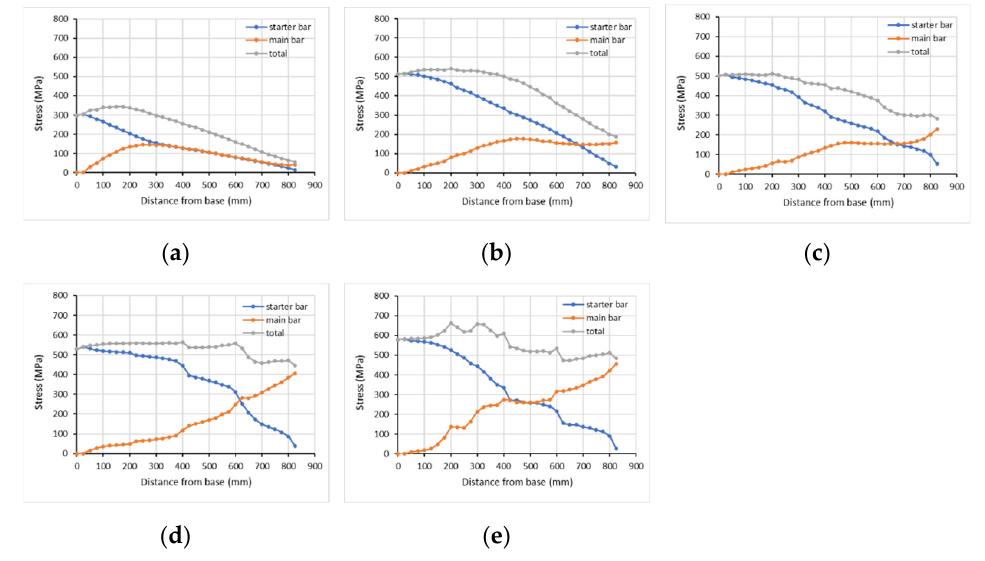
Figure 13. Developed stress along lap splice length at a displacement of ( a ) 4.70 mm, ( b ) 8.91 mm, ( c ) 12.02 mm ( δ y ), ( d ) 26.50 mm ( δ Pmax ), and ( e ) 96.27 mm ( δ u ), for column R-P2L4.